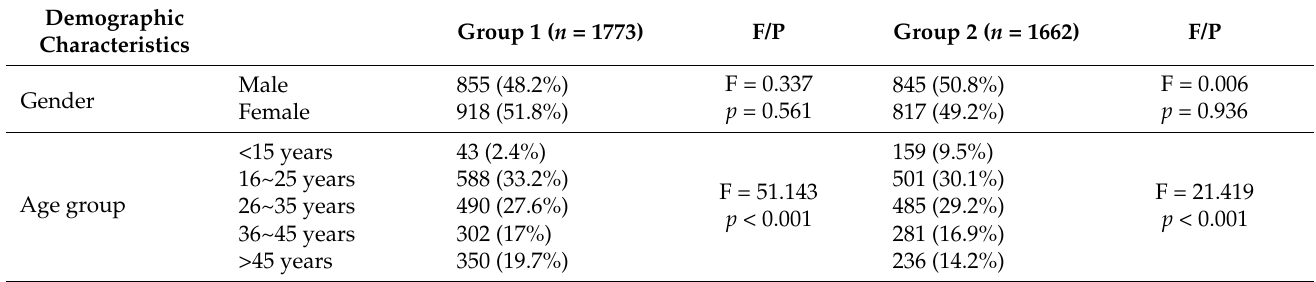
Table 5. Summary statistics of participants’ background information and the results of the one-way ANOVA with